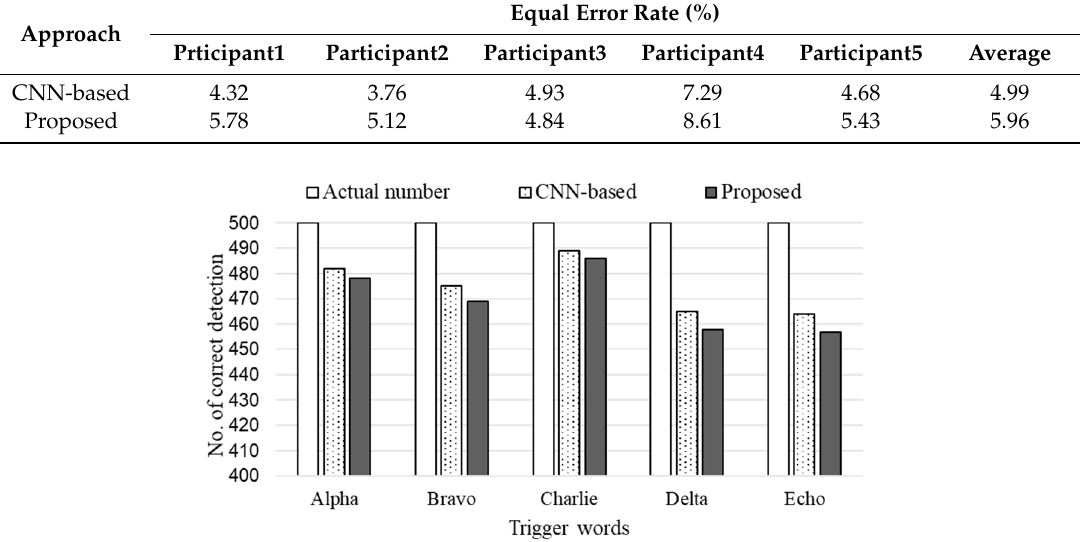
Table 3. Computation complexity of trigger word detection approaches.